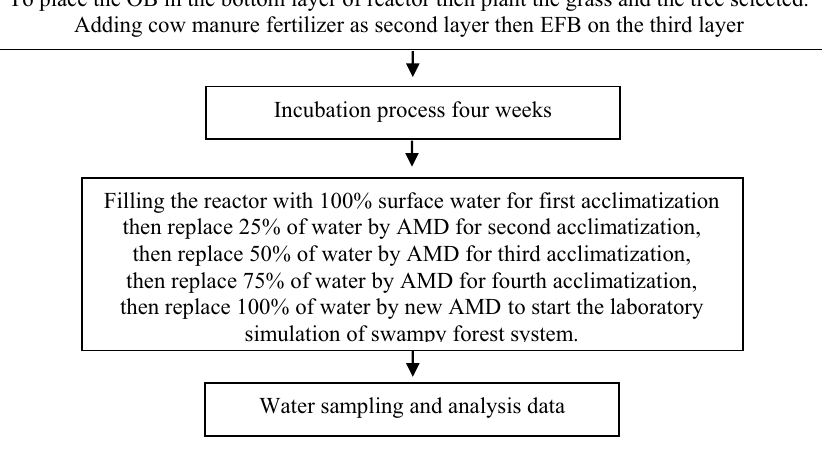
Figure 2. Flow chart of experimental procedure.